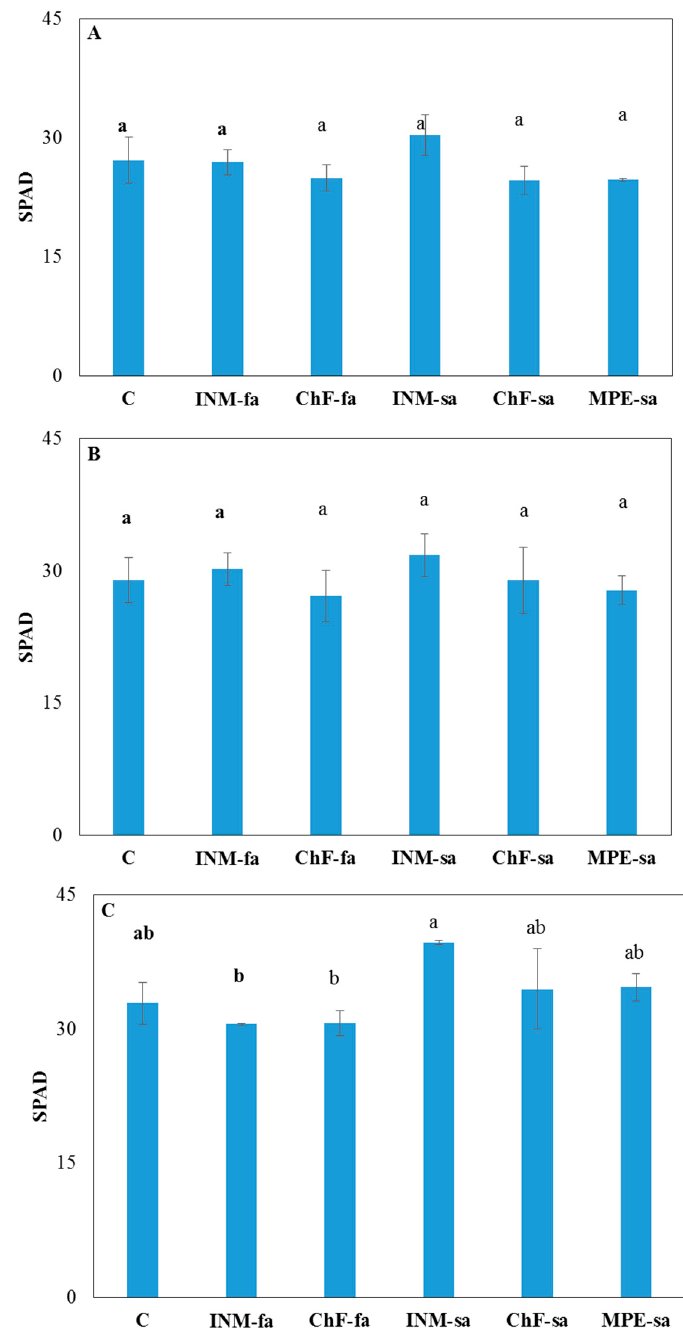
Figure 2. Effect of fertilization through different (root/foliar) application methods on leaf SPAD value of Origanum microphyllum at: ( A ) vegetative; ( B ) early flowering; ( C ) full flowering stage. C: control (water); INM: integrated nutrient management (INM) by foliar (INM-fa) or soil application (INM-sa); ChF: conventional fertilization by foliar (ChF-fa) or soil application (ChF-sa); MPE-sa: mixture of plant extracts as biostimulant by soil application. Values represent the mean of three replicates ± SEM. Within each plot different letters indicate significant differences.